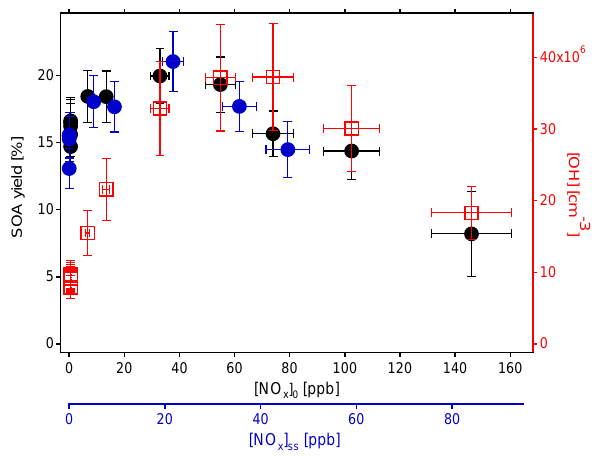
Figure 2. Measured SOA yield from PM max and from steady state PM (black and blue circles respectively) and measured OH concen- tration (red squares) as a function of initial ([NO x ] 0 ) and steady state ([NO x ] ss ) NO x concentrations. The errors in [OH] and [NO x ] were estimated to be ± 20 and ± 10% respectively. The error in SOA yield was estimated from error propagation using the sum of the sys- tematic error, correction procedure error and error in BVOC